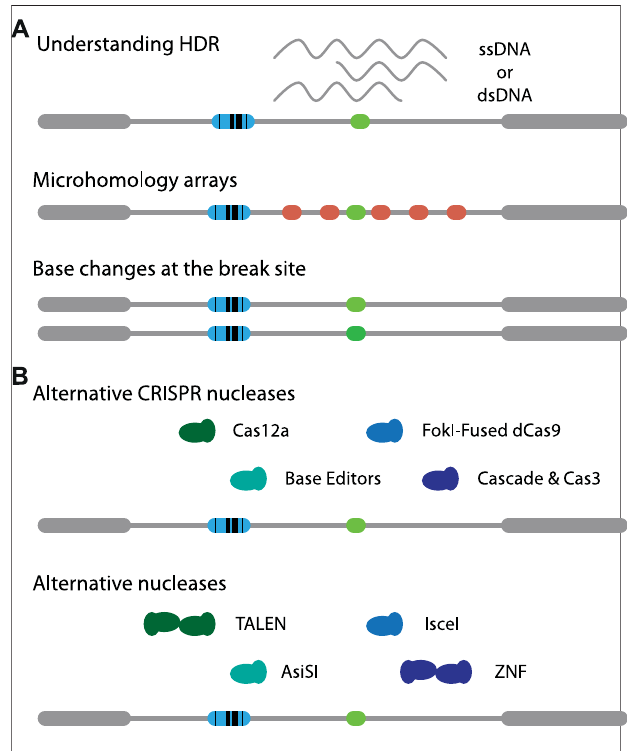
FIGURE 2 | Adaptations of DSB-TRIP. (A) Potential variations of the reporter itself. One can study the effects of chromatin on (1, top) MMEJ by creating tiled microhomologies (red), (2, middle) on Cas9 mutagenesis with small mismatches (middle) or (3, bottom) on HDR based transgenesis. (B) Illustration on variations on CRISPR nucleases (top) and other nucleases (bottom). Target cut site in light green, IPR barcode in